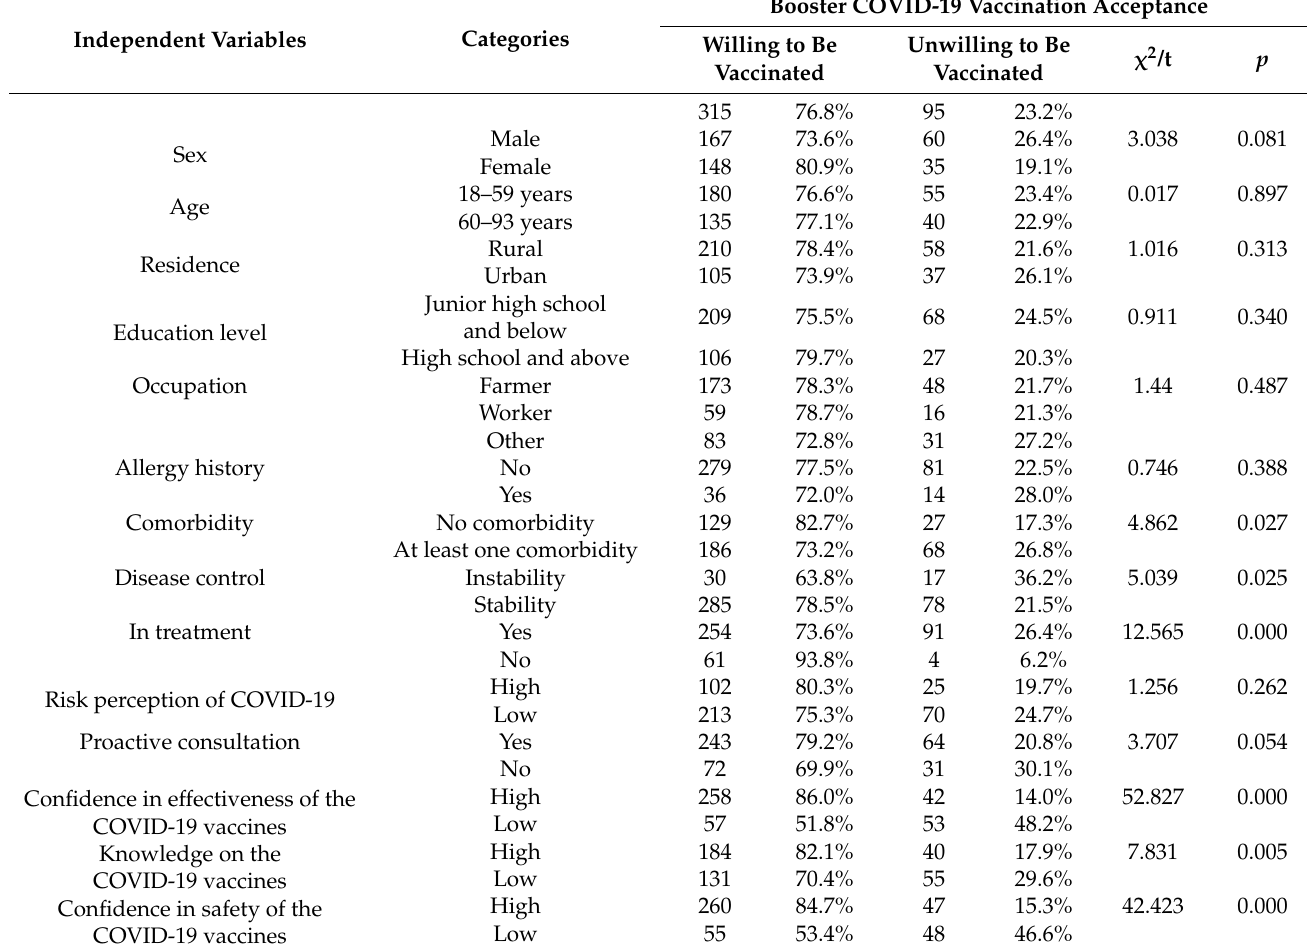
Table 2. Univariate analysis of factors associated with booster vaccination acceptance against COVID-19, N =